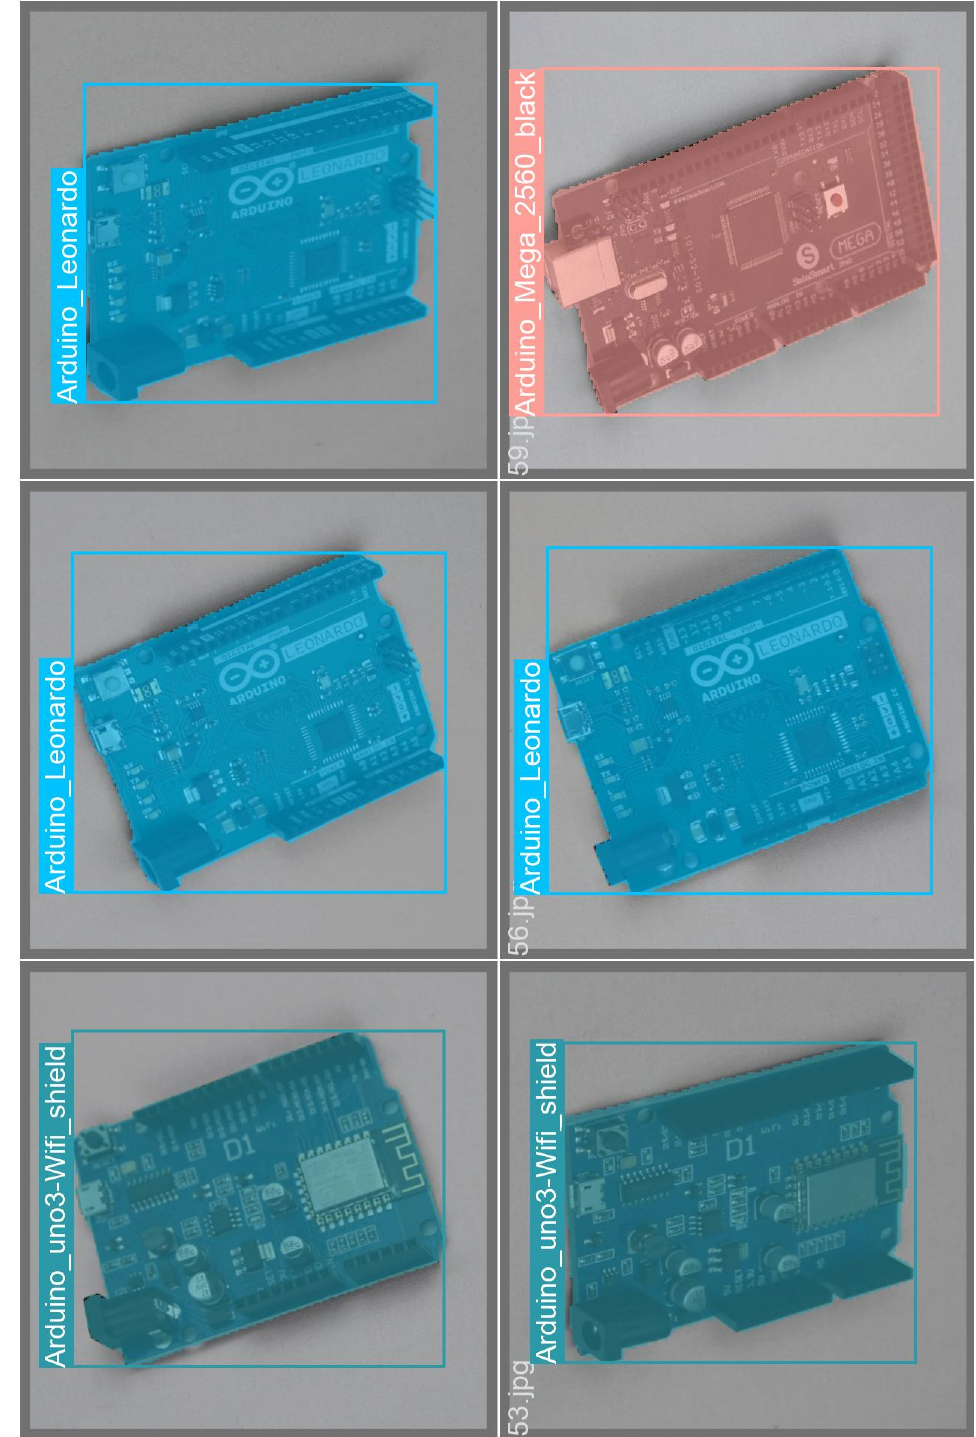
Figure A3. Second validation of data marked with